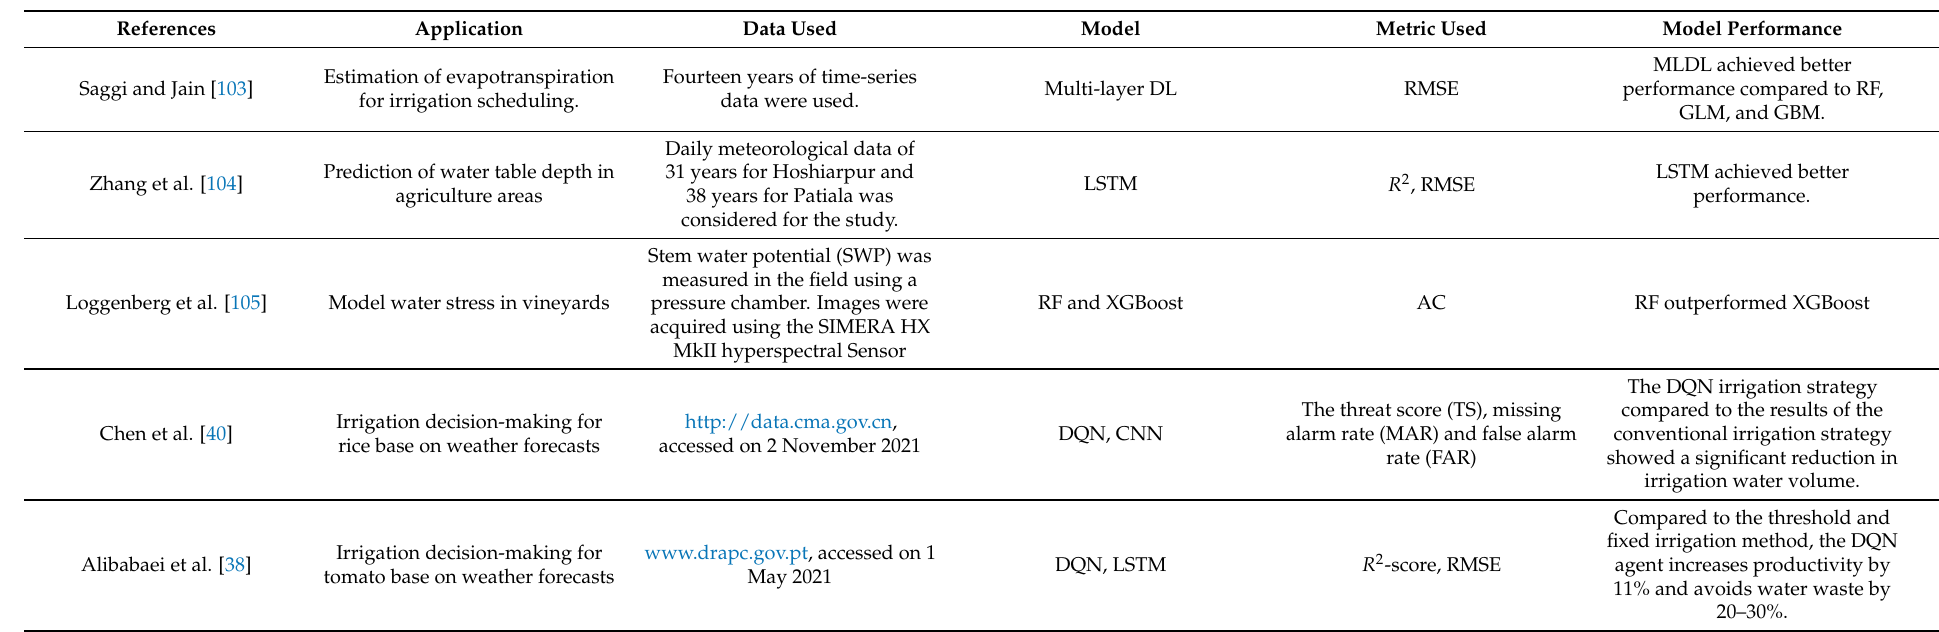
Table 8. Feature descriptions of recent published papers in the field of “Water